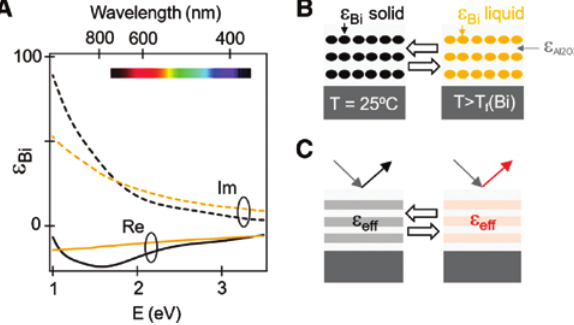
Figure 1: The working principle of the Bi-based PCM. (A) The spectra of the real and imaginary part of the dielectric function ε of solid Bi (black lines, from [25]) and liquid Bi (orange Bi lines, from [27]). (B) Simplified cross-section drawing of the PCM design consisting of a multilayer stack alternating composite Bi:Al O nanolayers with spacer layers made of Al O . Each 2 3 2 3 composite nanolayer consists of a 2D assembly of Bi nanostructures embedded in Al O . Upon increasing temperature above the Bi 2 3 melting point, the nanostructures melt and the dielectric function of each nanostructure changes from that of solid Bi to that of liquid Bi, represented in (A). (C) Therefore, upon melting the Bi nanostructures, the effective dielectric function ε of the composite eff nanolayers changes along with the optical reflection properties of the PCM. Note that the dielectric function ε of Al O does not Al2O3 2 3 change significantly over the range of temperatures